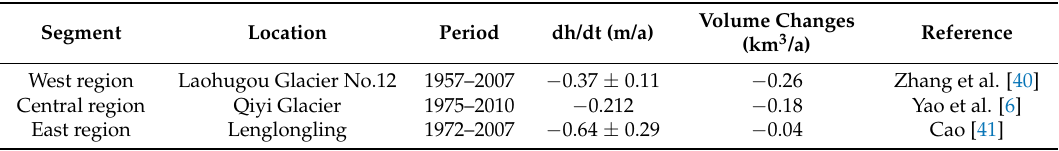
Table 5. Glacier volume changes results used in this study.